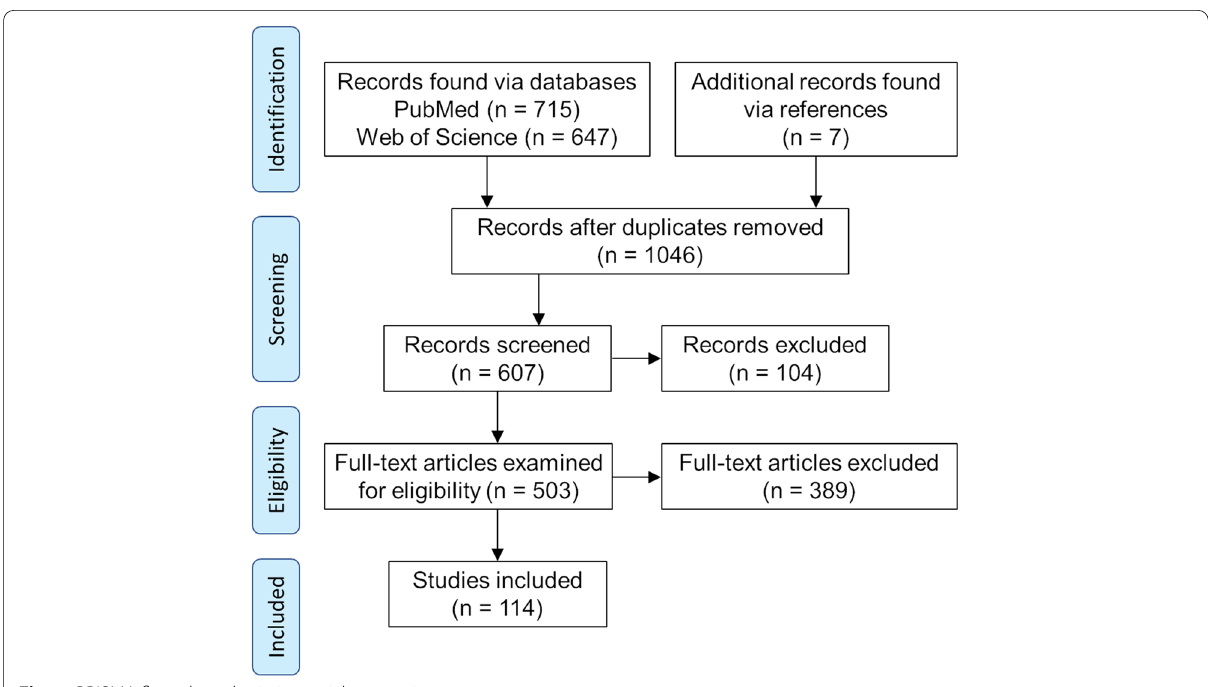
Fig. 1 PRISMA flow chart depicting article screening process Excluded works include reviews, short communications, case reports, articles written in non‑English languages, articles published in journals with impact factor < 2, citations, and articles which do not meet the definition of 3DBP. Example search terms include ((3D bioprint cartilage NOT (systematic review)) NOT